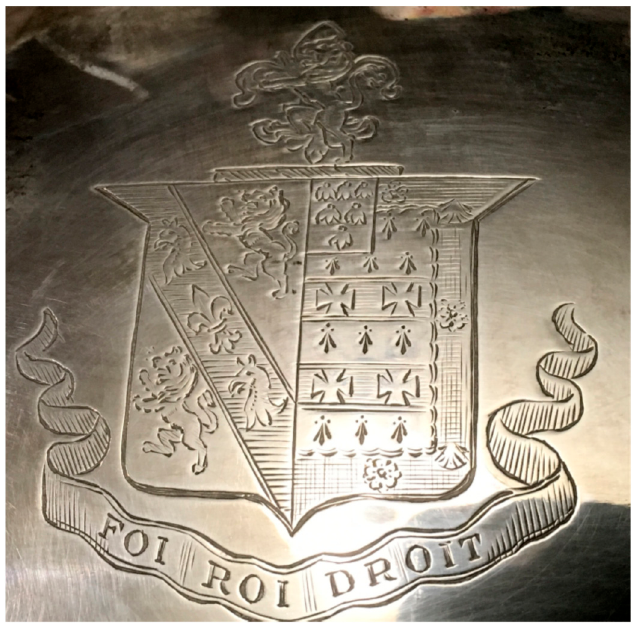
Figure 1. Engraving on silverware, used with permission.